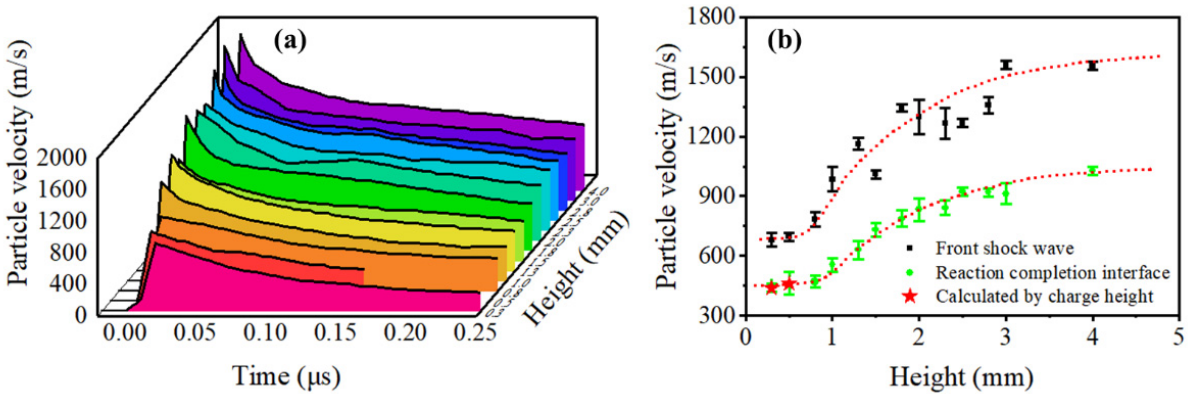
Figure 7. ( a ) Particle-velocity profiles at the heights of 0.3~4.0 mm. ( b ) Particle velocity of the shock front and reaction–completion interface as function of charge height.